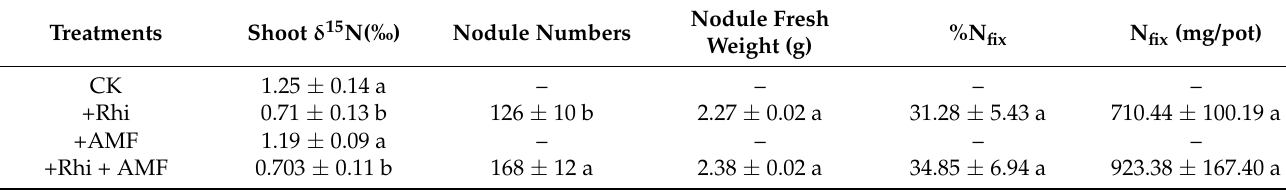
Table 1. N 2 -fixation capacity of nodulated white clover grown in pots. Treatments Shoot δ 15 N(‰)